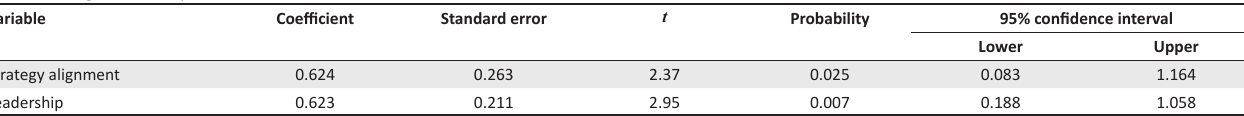
TABLE 5b: Organisational